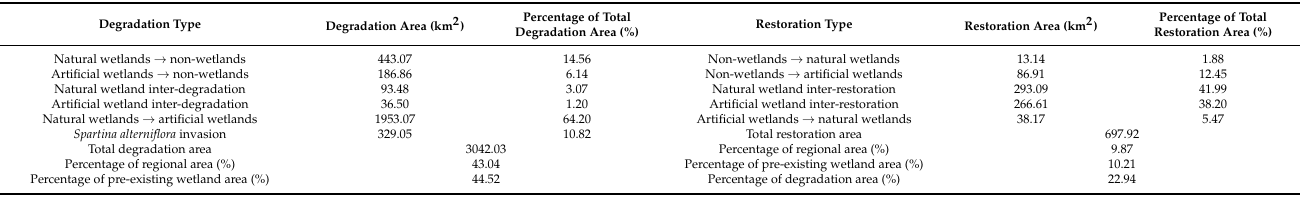
Table 3. Statistics of the landscape evolution over the last 40